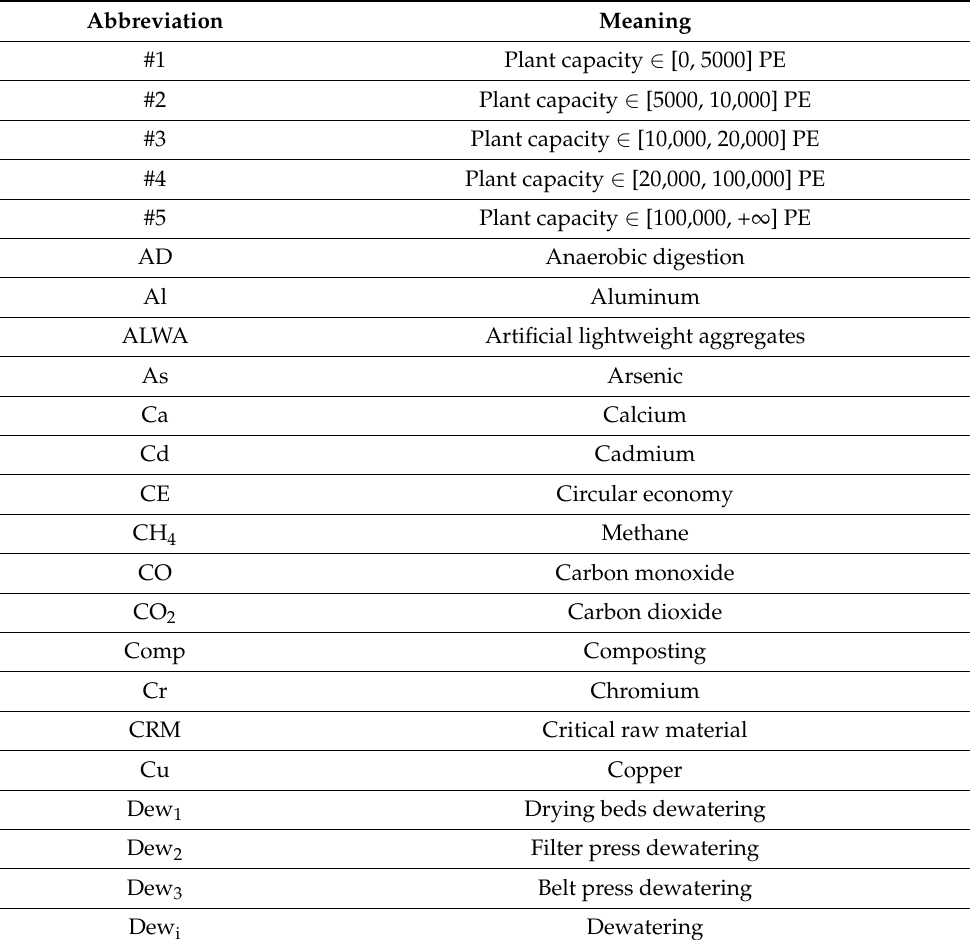
Table A1. List of abbreviations and